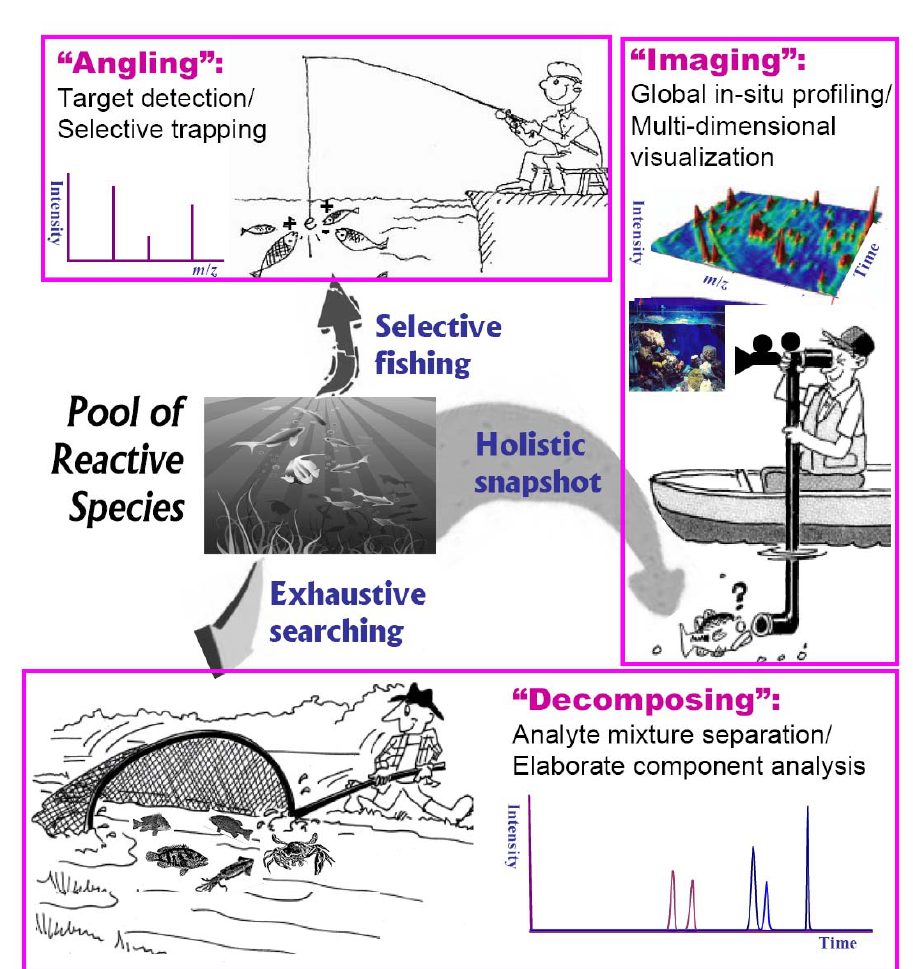
Figure 2. Sketch of generic ESI-MS strategies for probing reaction intermediates in solution: angling (selective fishing), decomposing (exhaustive searching) and imaging (holistic